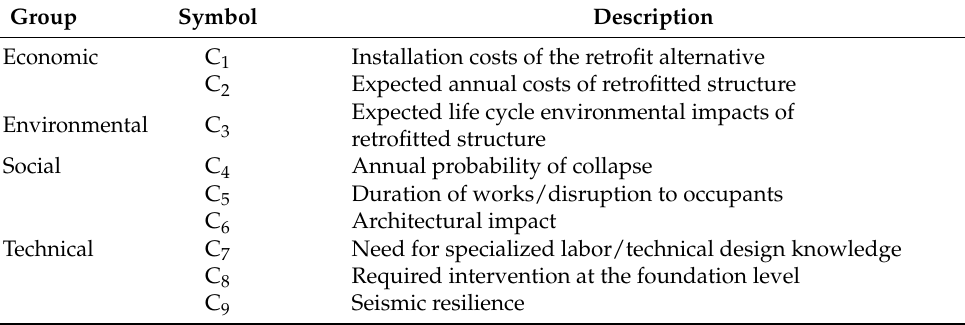
Table 5. Evaluation parameters adopted for MCDM to select an optimal retrofit alternative